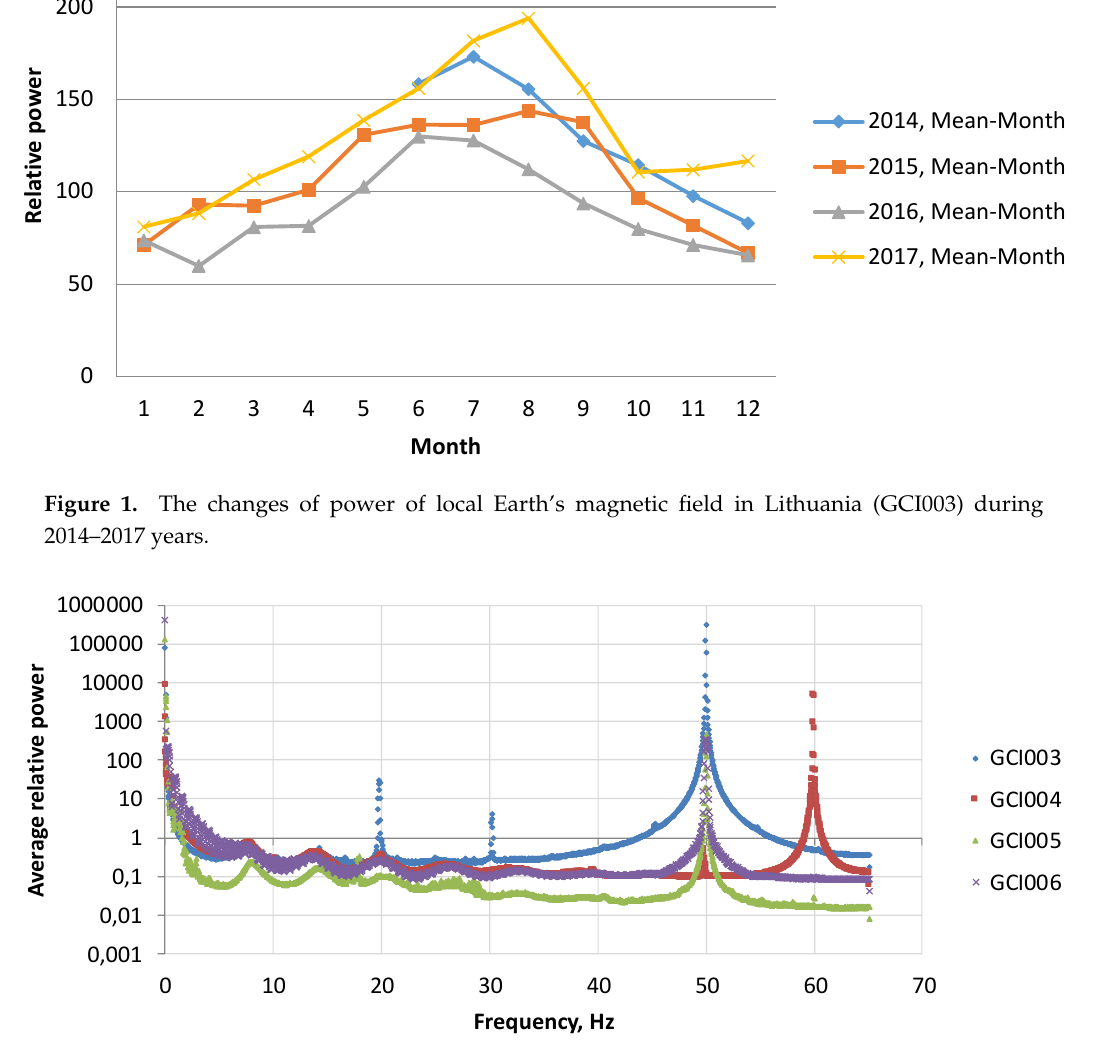
Figure 2. Schumann resonances 24 April 2016 through 30 April 2016 for magnetometers GCI003— Lithuania; GCI004—Canada; GCI005—New Zealand; and GCI006—South Africa.